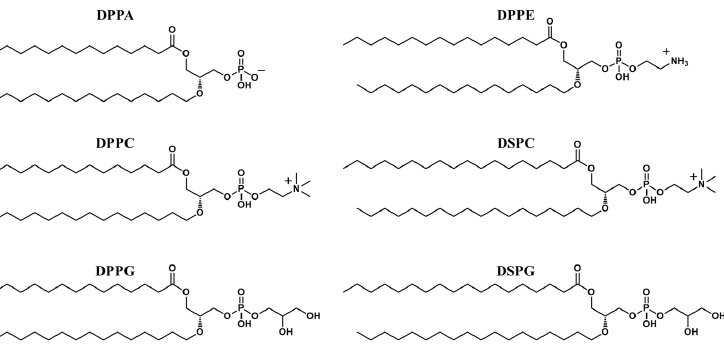
Figure 1. Structure of phospholipids used in microbubble synthesis. (DPPA, dipalmitoyl phosphoric acid; DPPE, dipalmitoylphosphatidylethanolamine; DPPC, dipalmitoylphosphatidylcholine; DPPG, dipalmitoylphosphatidylglycerol; DSPC, distearoylphosphatidylcholine; DSPG, distearoylphosphatidylglycerol).